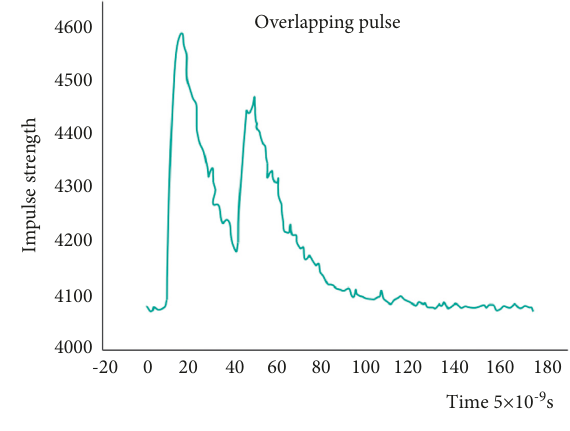
Figure 3: Overlapping